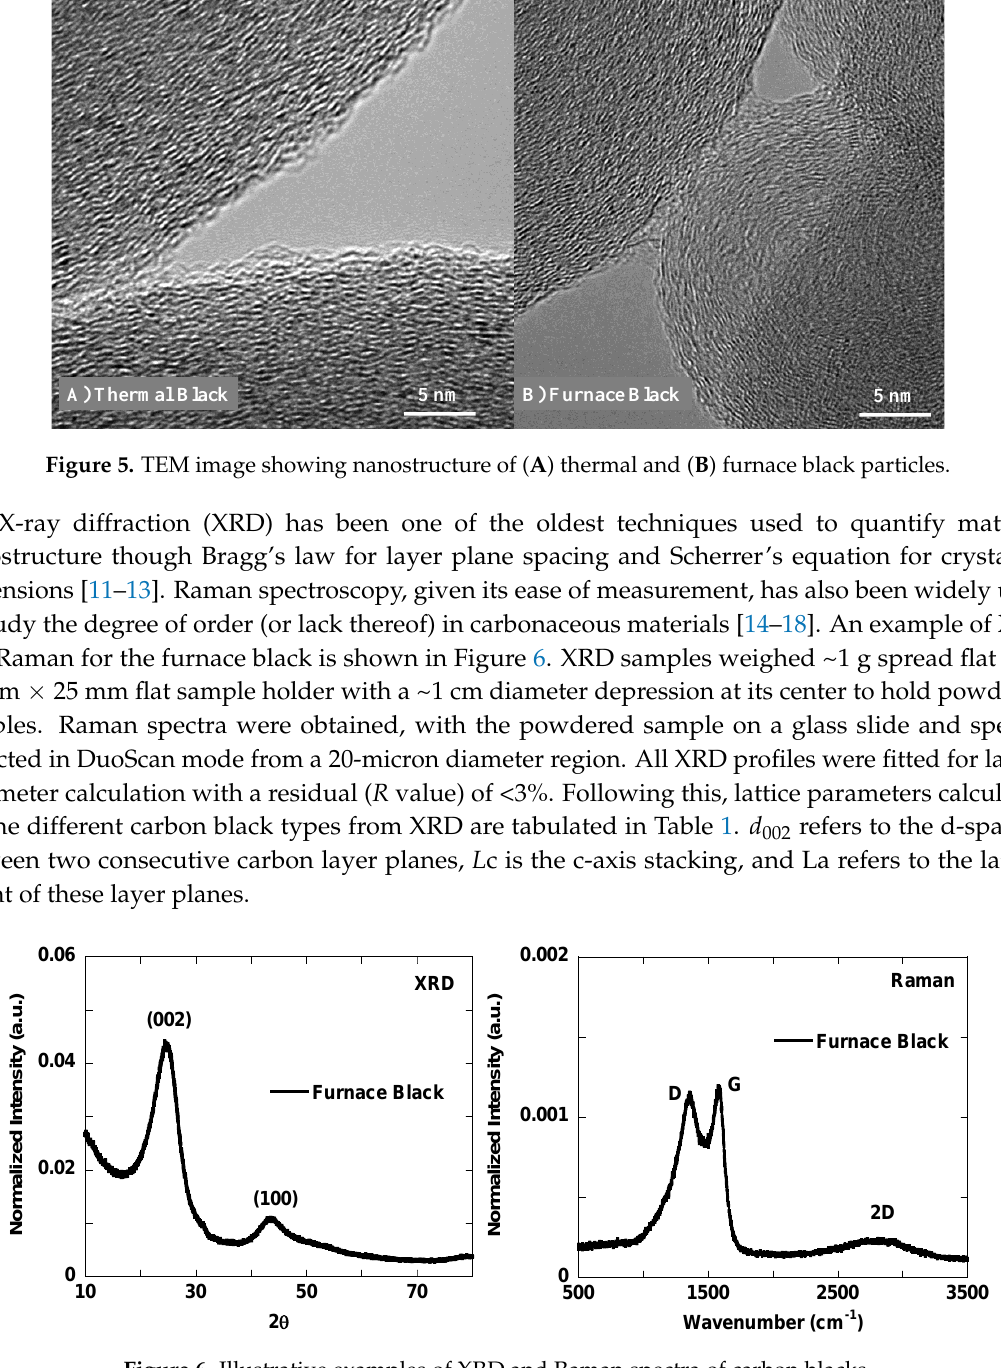
Figure 4 . TEM images contrasting a ( A ) high and a ( B ) low degree of aggregation in the different carbon blacks.